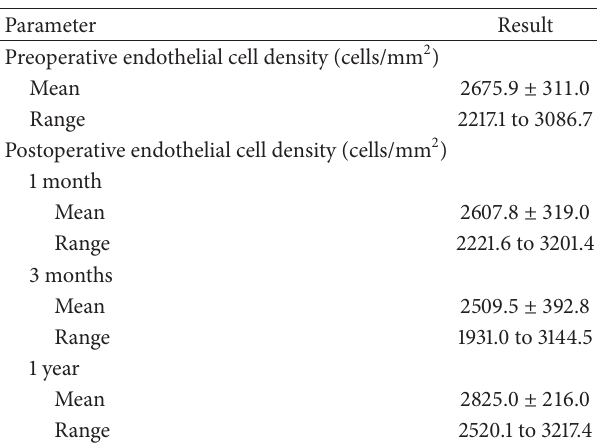
Figure 4: Box plot of laser flare values over time. Gray boxes span the 1st quartile to the 3rd quartile, including the median. Whiskers denote the lower and higher extreme within the 1.5 interquartile range. Circles denote mild outliers; asterisks denote extreme out- liers. Square brackets denote statistical significant increases of laser flare values compared to baseline. Table 3: Endothelial cell